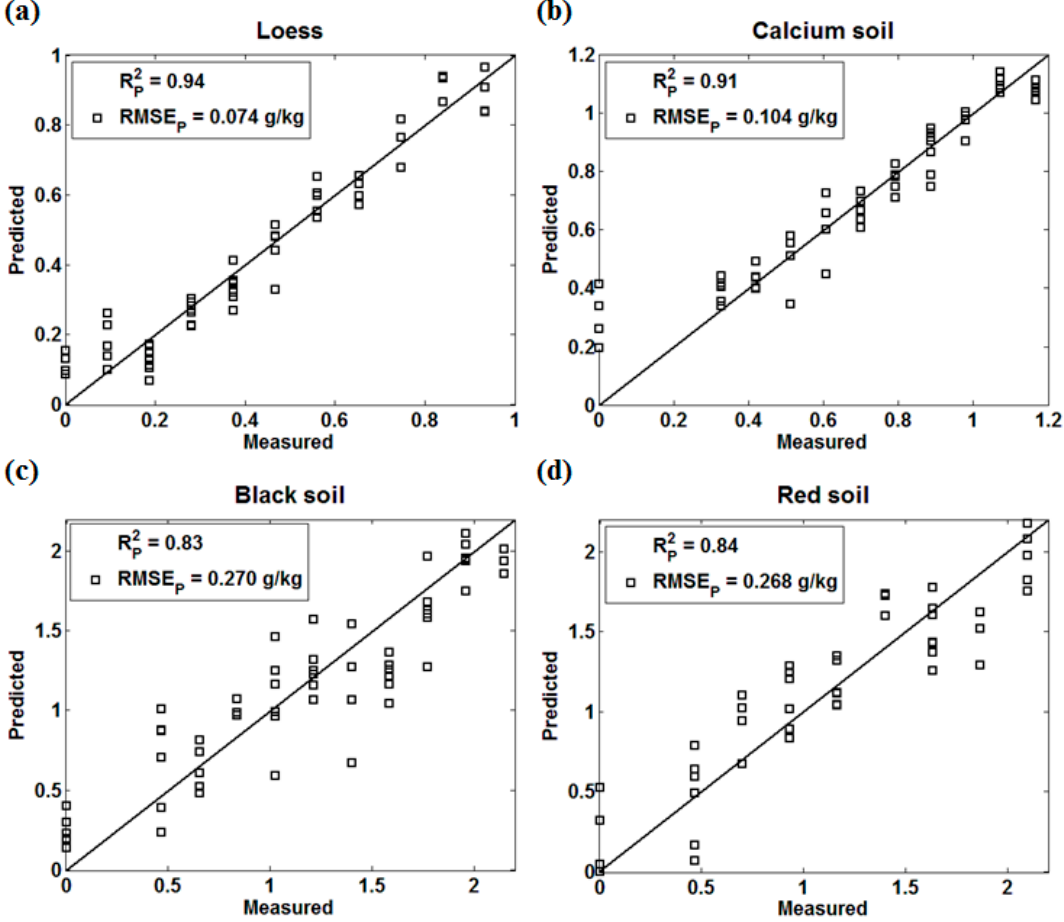
Figure 7. The sensitive waveband modeling effect of four kinds of soils ( a ) Loess; ( b ) Calcium soil; ( c ) Black Soil; ( d ) Red soil.